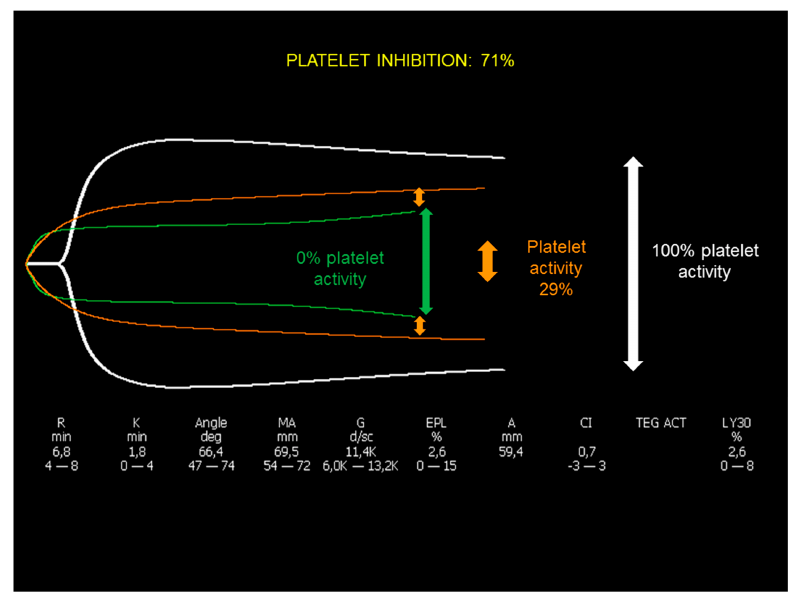
Figure 4. Thromboelastography (TEG) platelet mapping. White trace is standard TEG activated with kaolin; green trace is a platelet-free clot obtained by adding heparin and reptilase; orange tracing is the platelet activity, adding a specific platelet activator (arachidonic acid or ADP).